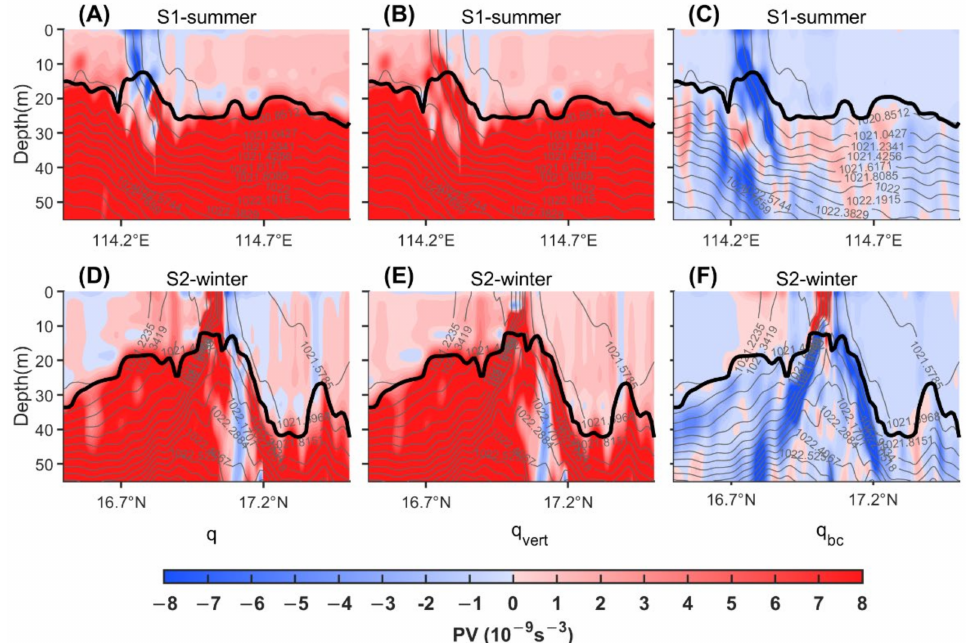
Figure 8. Vertical profiles of Ertel PV q and its sub-components for S1 and S2 marked in Figure 7A, D. ( A ) the Ertel PV q , ( B ) the vertical component and ( C ) the baroclinic component on 5 July. ( D ) the Ertel PV q , ( E ) the vertical component and ( F ) the baroclinic component on 4 December. The bold black line denotes the mixed layer depth, and the gray contours indicate the isopycnals (kg · m − 3